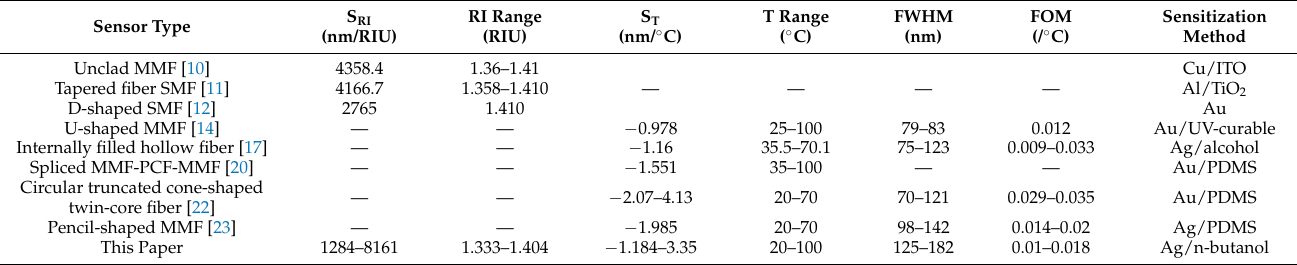
Table 1. Comparison of the proposed sensor with other sensors’